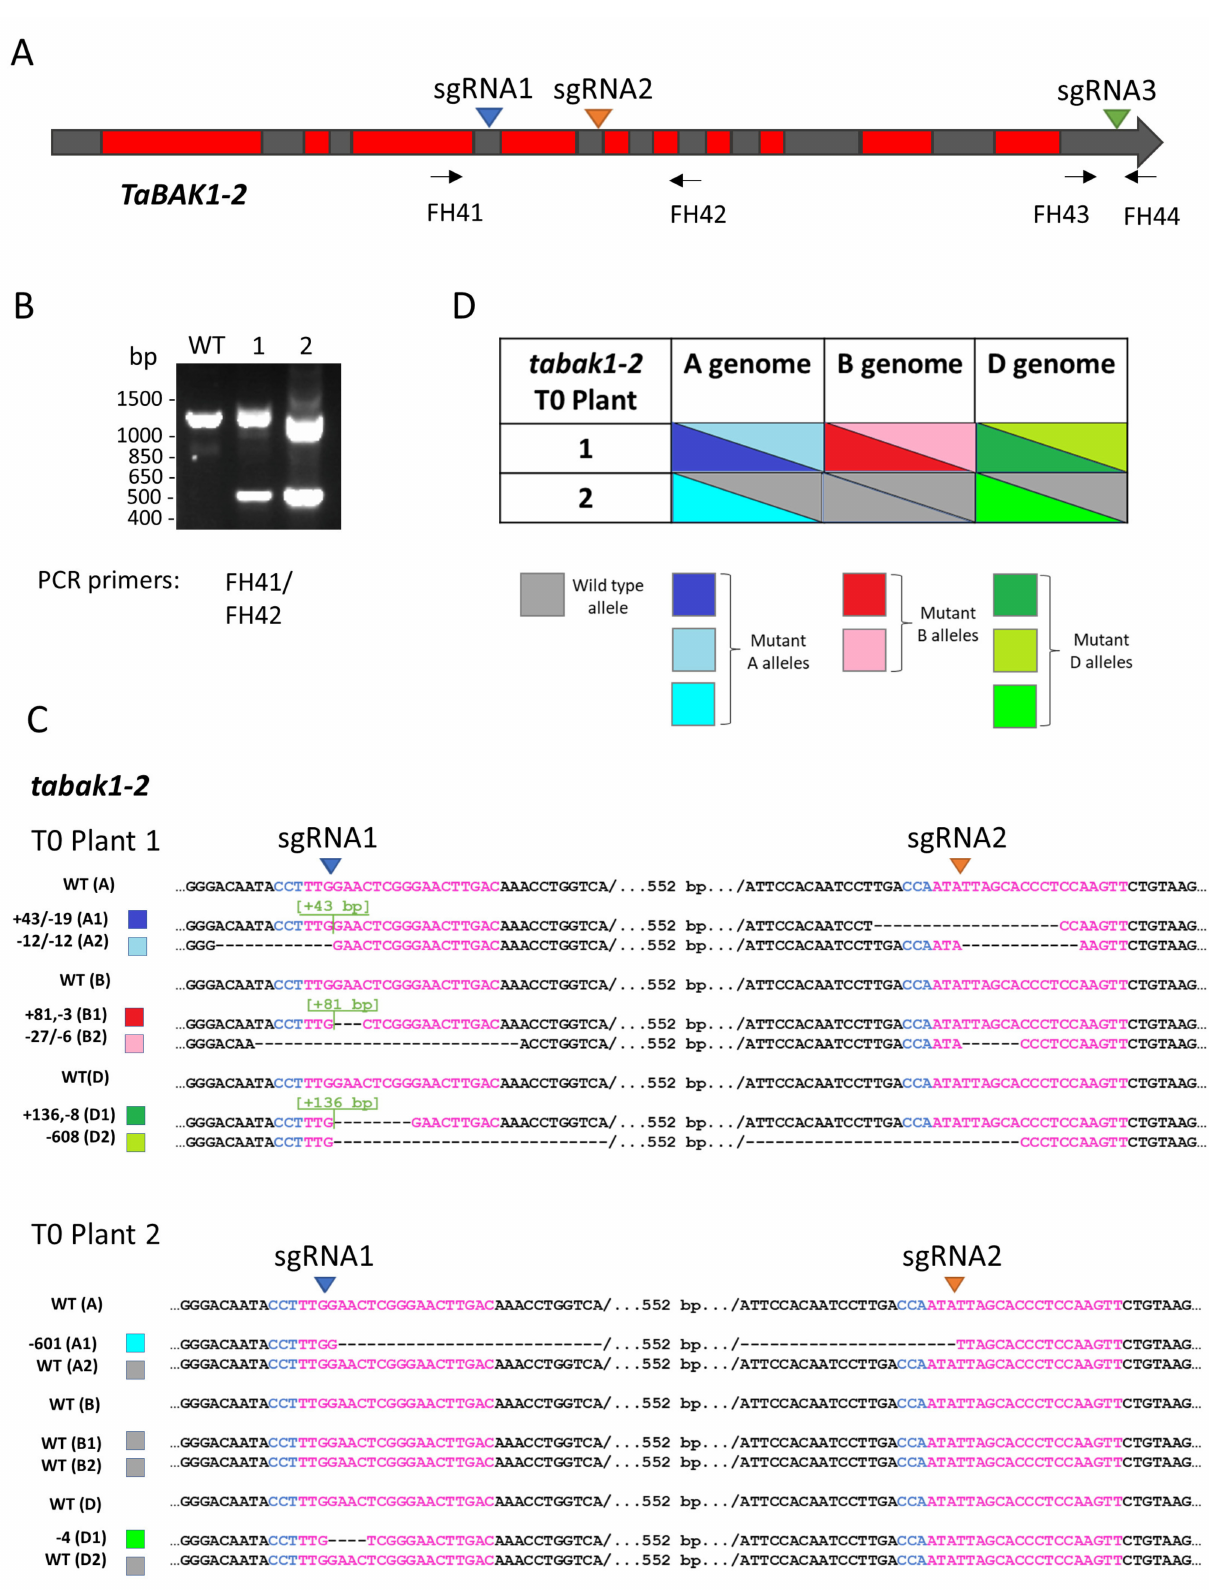
Figure 1. Targeted mutagenesis of TaBAK1-2 . ( A ) Cartoon showing locations of sgRNA target sites, ( B ) PCR genotyping of CRISPR/Cas-mutagenised T0 lines, ( C ) mutant tabak1-2 alleles identified by Sanger sequencing in T0 plants and ( D ) allele composition of tabak1-2 T0 plants. PCR primers used for genotyping are shown as